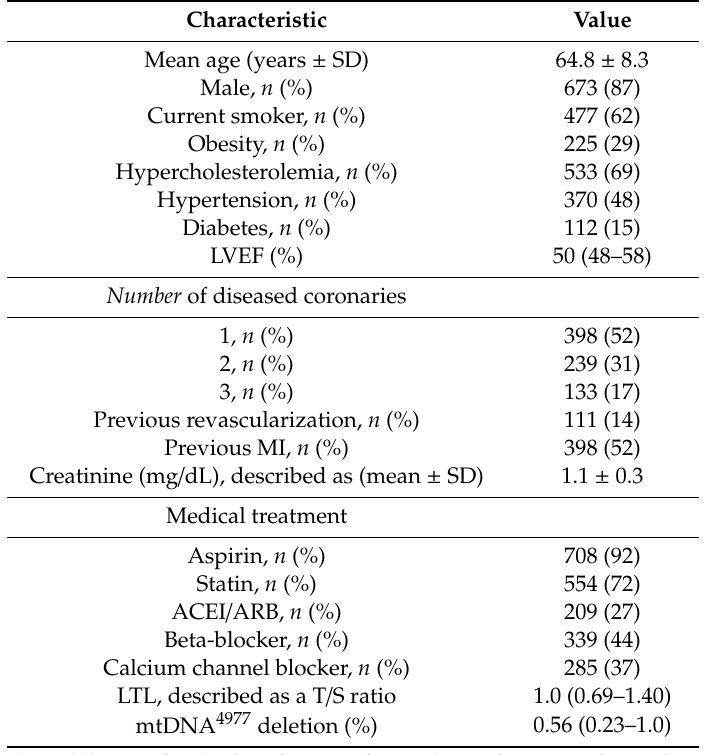
Figure 1. Kaplan–Maier plot of major adverse cardiovascular events (MACEs) and all-cause mortality for the leucocyte telomere length (LTL) and mtDNA 4977 deletion. LTLs of <median value and ≥ median value are stratified as short and long LTLs, respectively. mtDNA 4977 deletion levels of >median value and ≤ median value are classified as high and low mtDNA 4977 deletion levels, respectively. Table 1. Demographic and clinical characteristics of the study